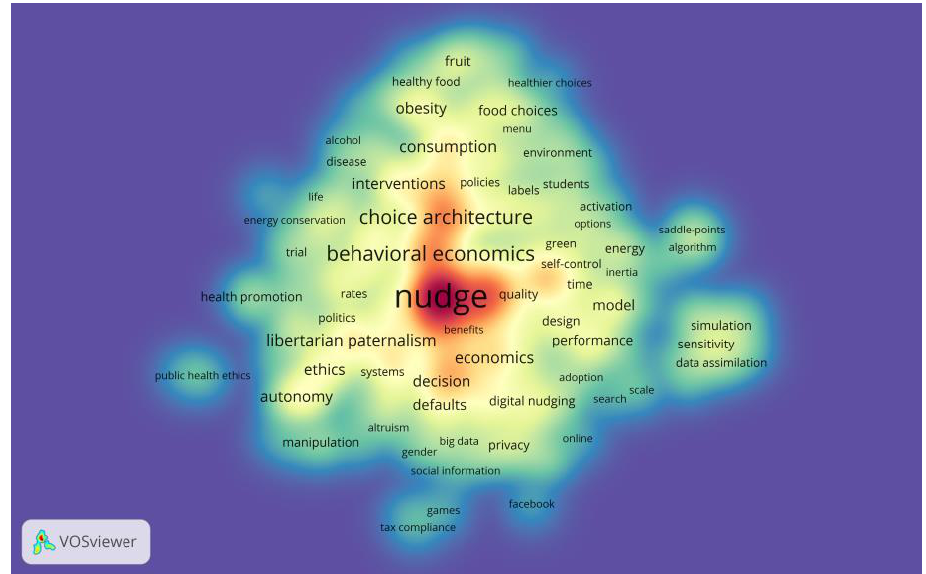
Figure 10. Density visualization of keyword co-occurrence analysis.